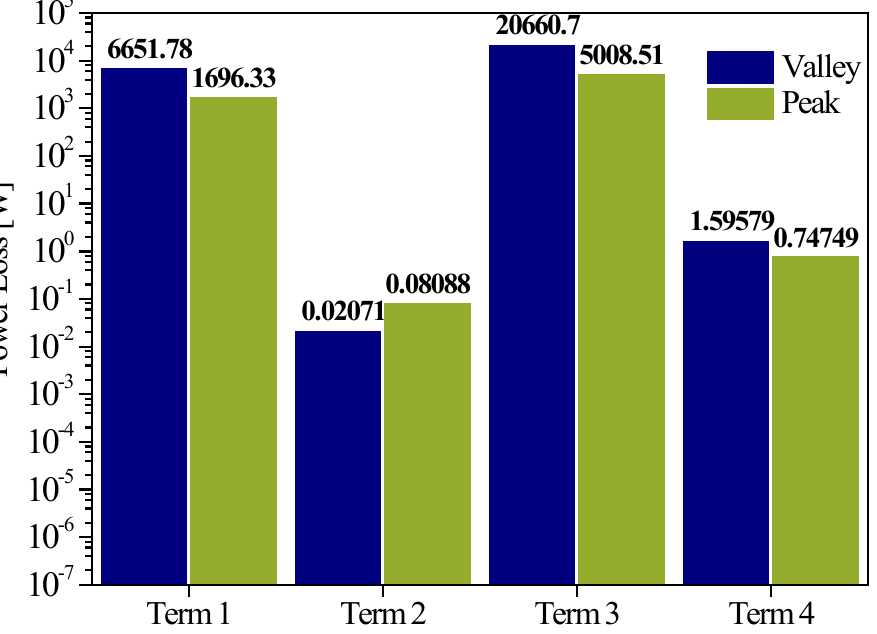
Figure 11. The power loss composition in volute under the peak and valley condition. Table 4. The flow pattern and power loss distribution in volute under hump condition. Streamline Term1 Term3